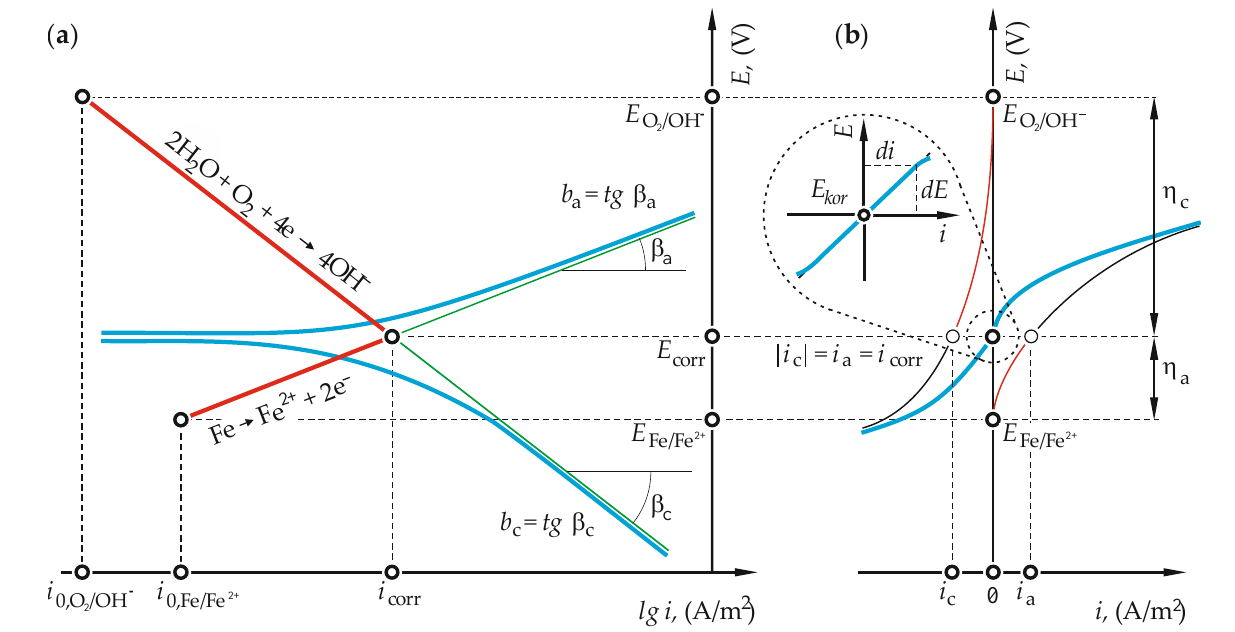
Figure 1. The mechanism of development of corrosion potential on iron surface: ( a ) E – i diagram on logarithmic scale; and ( b ) E – i diagram on arithmetic scale — description and notes in the text.